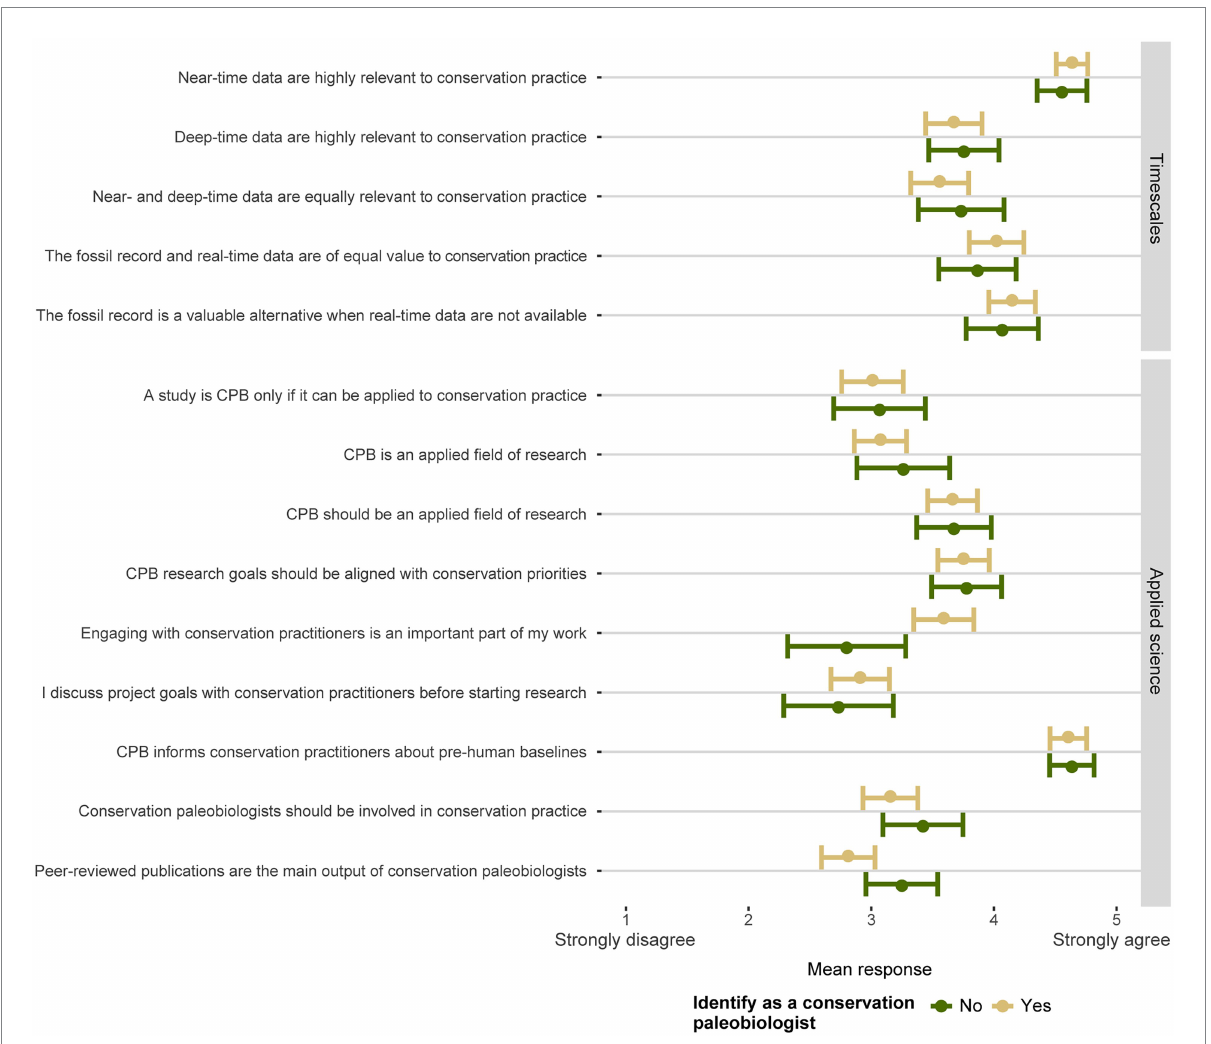
FIGURE 7 Mean participant responses to survey questions about the conservation relevance of different timescales (top) and the application of CPB to conservation practice (bottom). Conservation practice was defined as all aspects of conservation, restoration, and management. The responses were recorded on a Likert scale from 1 (strongly disagree) to 5 (strongly agree). The points and error bars show the mean and 95% confidence intervals of responses to each question, colored by whether a participant self-identified as a conservation paleobiologist. See Supplementary Figure S13 for a full breakdown of the Likert